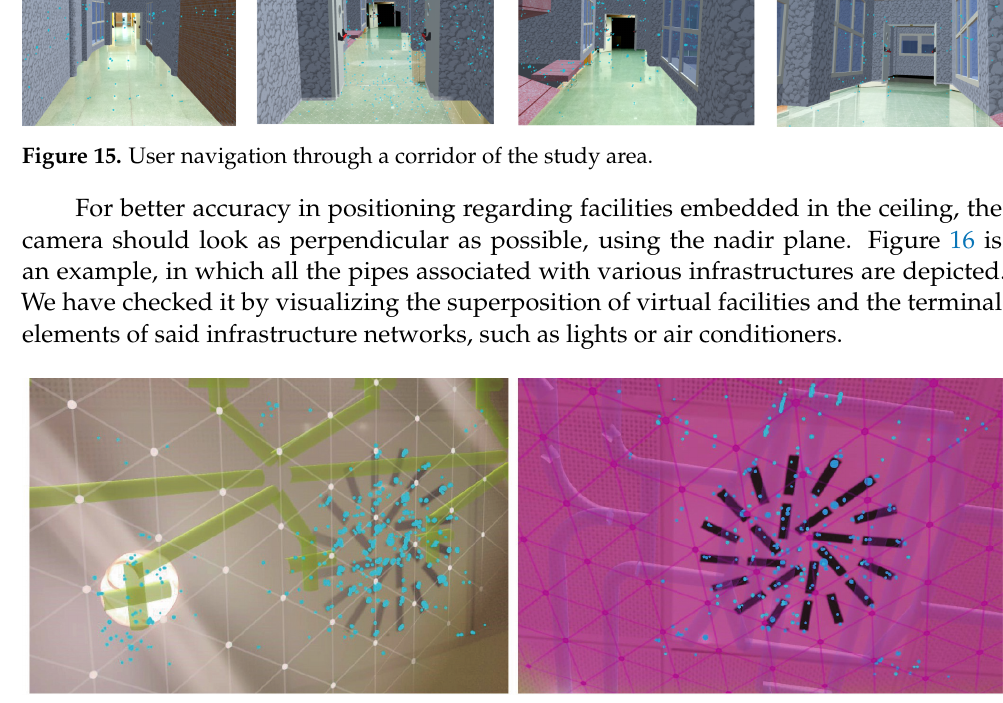
Figure 16. Nadir visualization of electrical and air-conditioning